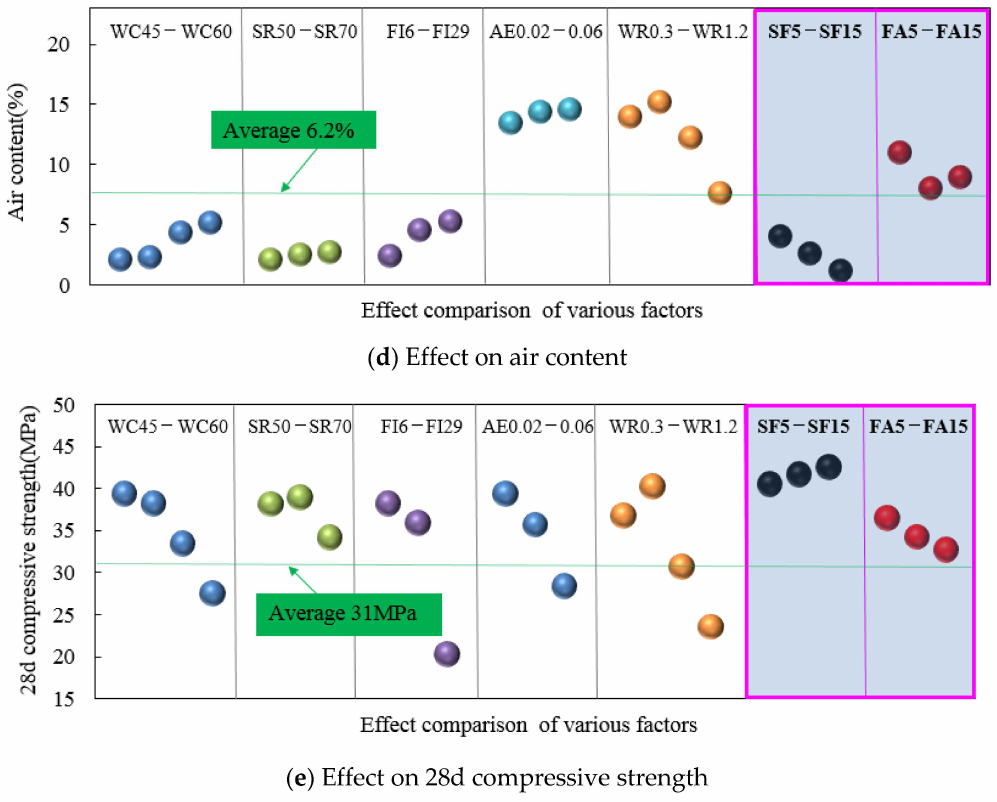
Figure 21. Comparative analysis of influence between fly ash, silica fume, and other factors. In the aspect of relative yield stress, the effect of silica fume (SF) on the yield stress of wet shotcrete is similar to that of low water–binder ratio (WC), medium sand ratio (SR) and fiber (FI), almost exceeding the average value of 0.745 Nm. Fly ash (FA) and